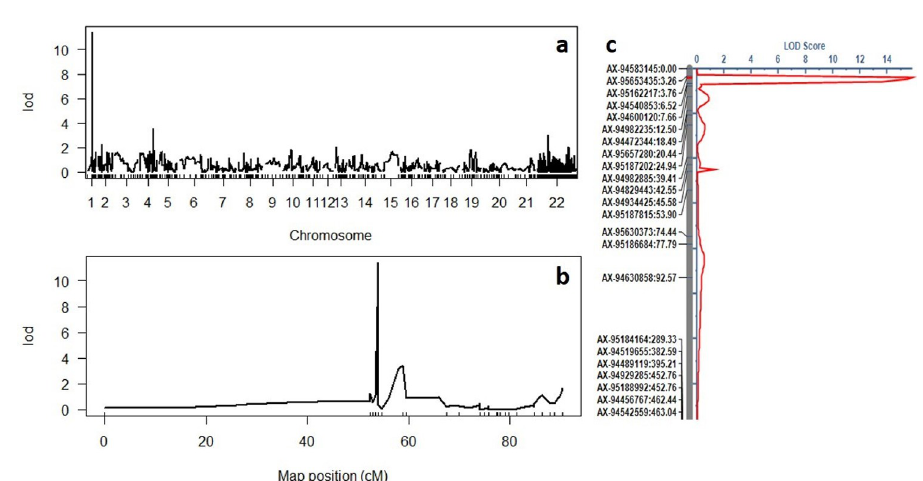
Fig 1. (a) Genome wide marker trait associations for stripe rust resistance in Acienda/HD2967 BC 1 F 3 population generated in R/qtl showing a single large peak on chromosome 1A. (b) LOD scores for chromosome 1A depicting mapping of Yraci (c) Mapping of stripe rust resistance in Acienda/HD2967 population on wheat chromosome 1A using ICI Mapping software. Physical locations of the markers are indicated in